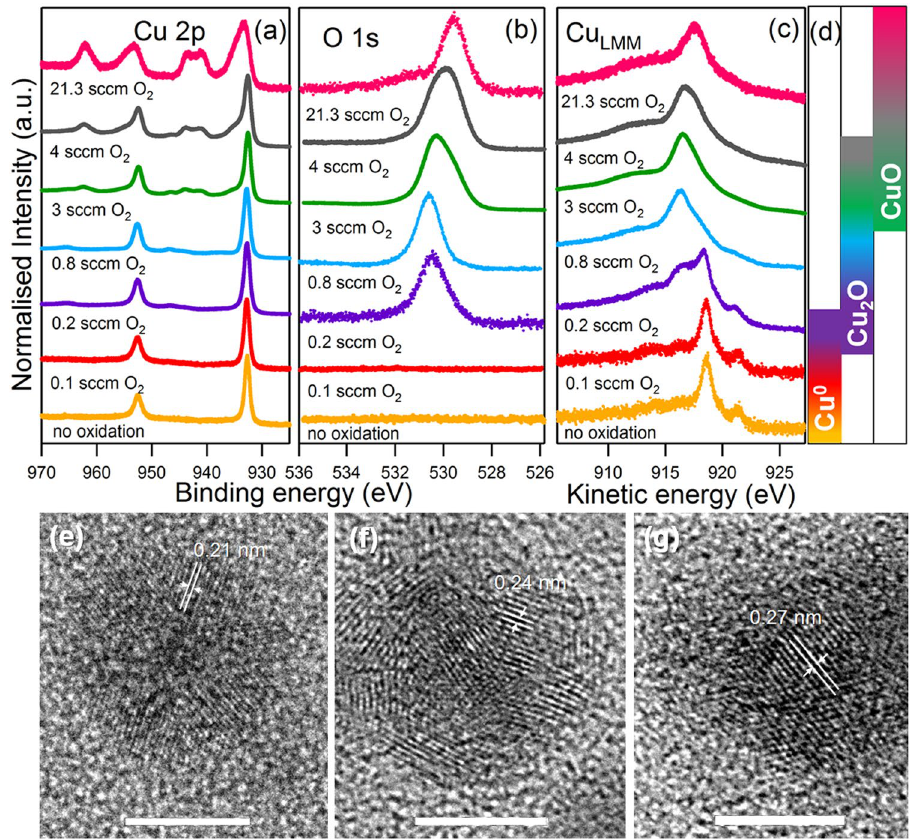
Figure 6. ( a ) Cu 2p, ( b ) O 1 s core levels and ( c ) Cu LMM Auger peak of Cu NPs after different O 2 treatments using gas entry point − 2. ( d ) Diagram of the formation and coexistence of the Cu species with φ O2 . TEM images of ( e ) Cu 0 , ( f ) Cu 2 O and ( g ) CuO nanoparticles. Scale bar: 5